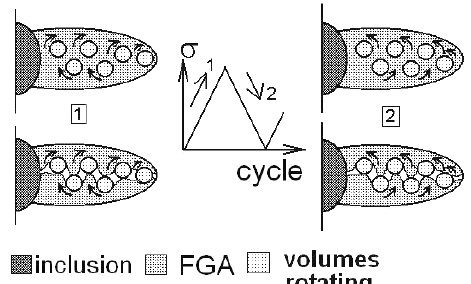
Figure 2: Schema of the spherical particles formation in FGA origin after ultra-high-plasticity in some metal’s